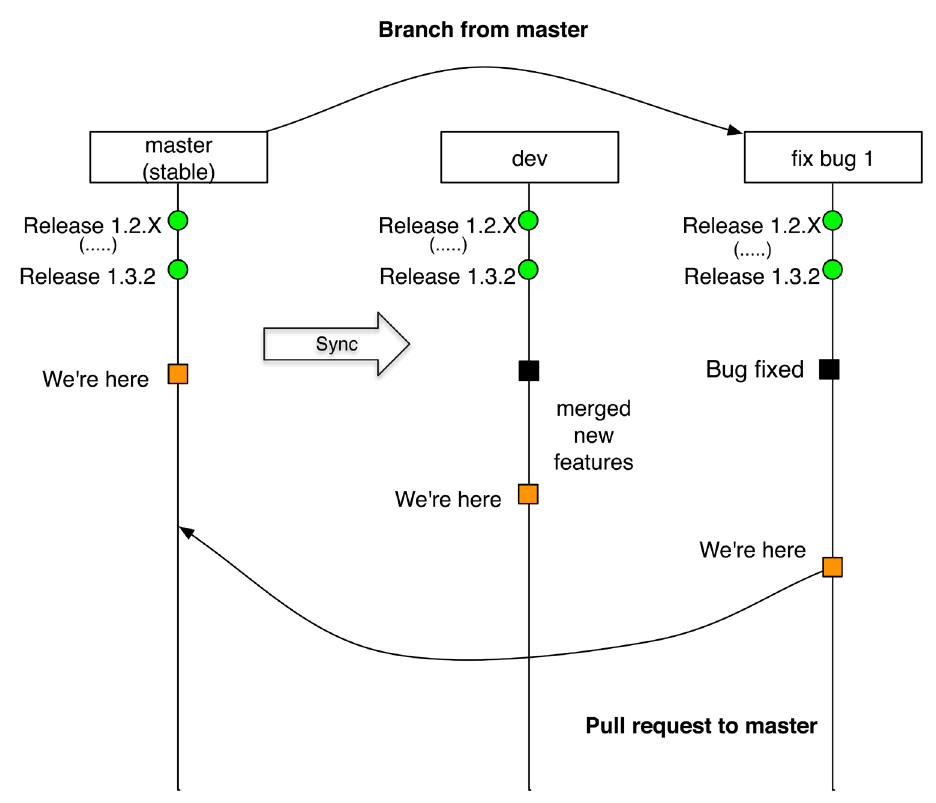
Figure 2. Example of a strategy for SCM workflow based on Git. It is an example of a bug fix branch from master branch and created a pull request with the changes against master branch.